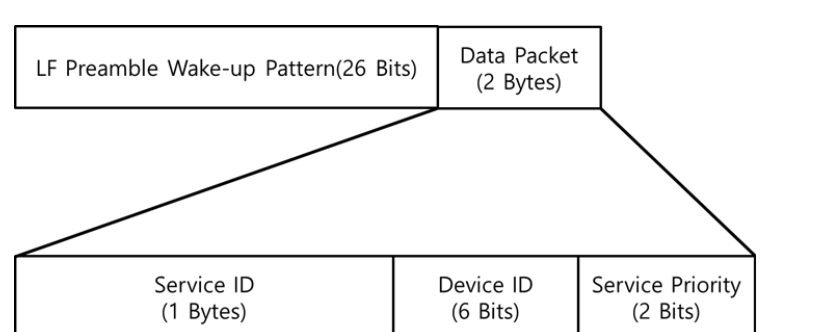
Figure 7. Sequence Diagram of Activity Event Report.